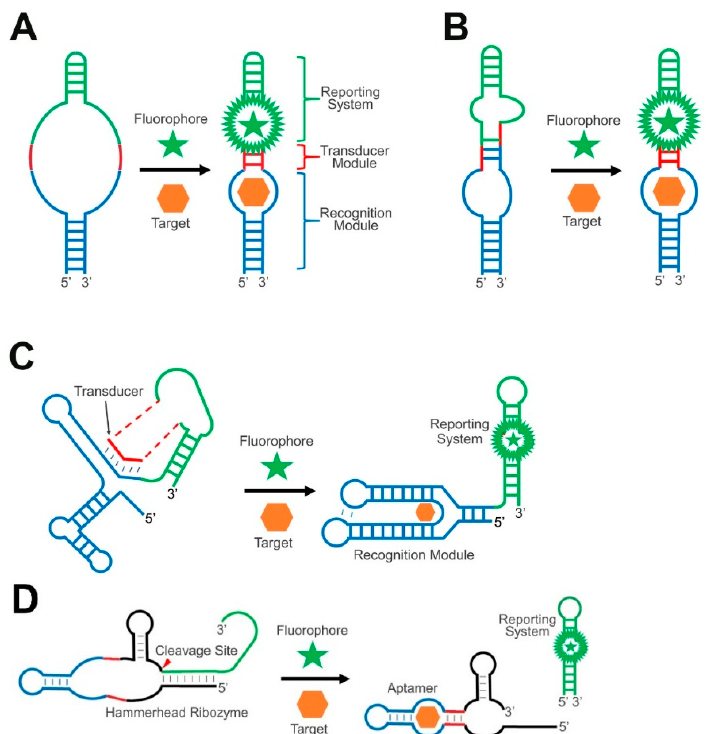
Figure 1. Schematics of different types of transducer module in GERMS. ( A ) The target binding-induced proper folding of the recognition module (blue) can trigger the formation of RNA duplexes (red), which further activate the reporting system (green). ( B ) The target binding induces helix slipping in the transducer module (red) to generate the signal. ( C ) Similar to natural riboswitches, the target binding induces the strand displacement of the transducer sequence (red) from the recognition module (blue) to the reporting system (green). ( D ) The target binding induces the folding (red) and activation of a hammerhead ribozyme to induce the catalytic cleavage and activation of the reporting system (green).